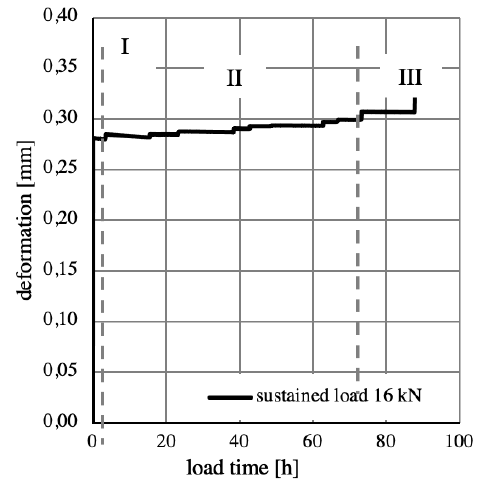
Figure 6. Experimental set-up for compression tests under continuous load and exposure to humidity, tem- perature and alkalinity; 1 hydraulic jack and oil pres- sure sensor; 2 test specimen; 3 temperature regula- tion; 4 stainless-steel profiles for guiding the speci- men.